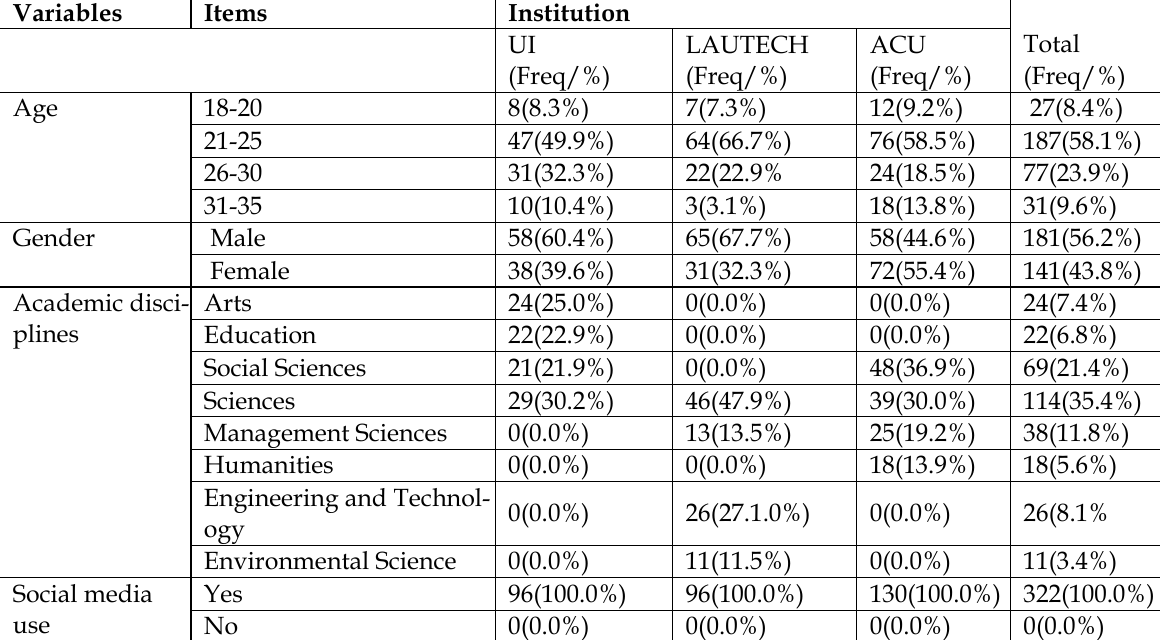
Table 4: Respondents’ distribution based on demographic characteristics